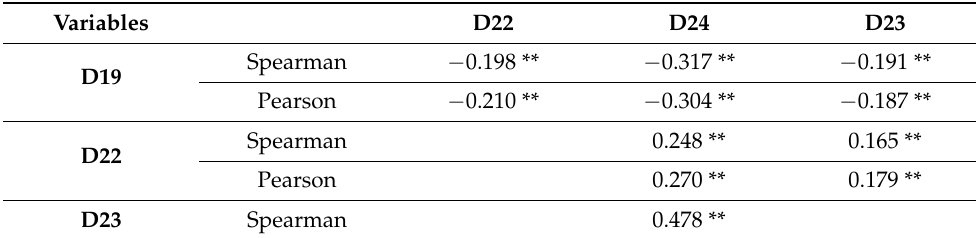
Table 4. Correlations between studied variables.